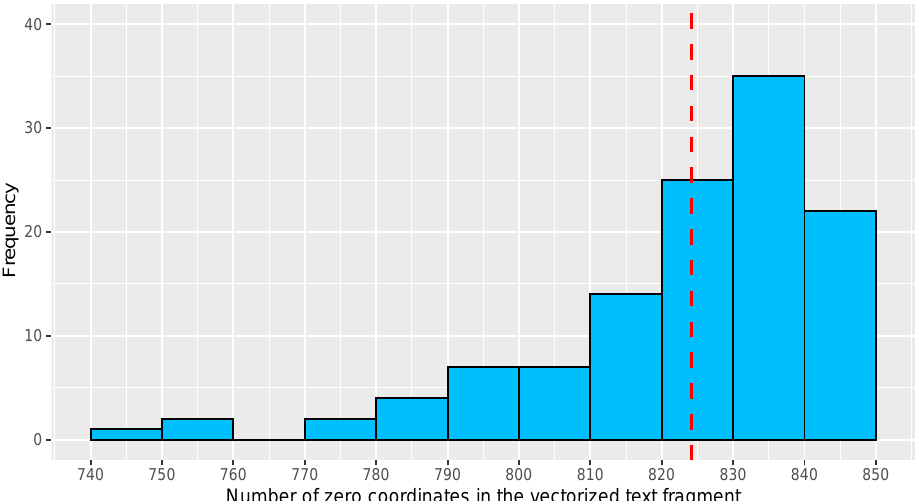
Figure 2. Histogram showing the sparsity of the vectorized training set. The horizontal axis shows the number of coordinates that are zero in the vectors resulting from the vectorization of the text fragments conforming the training set, while the vertical axis shows the absolute frequency of occurrence. The red vertical dashed line represents the average number of coordinates that are zero in the vectorized text fragments that form the training set.